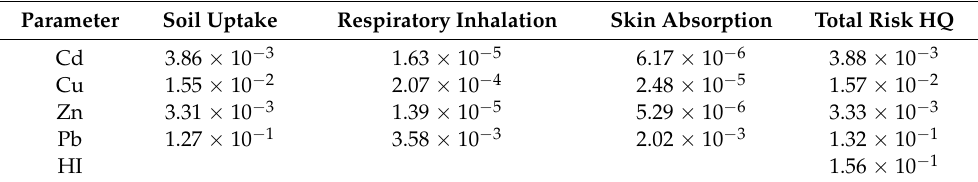
Table 6. Assessment of health exposure